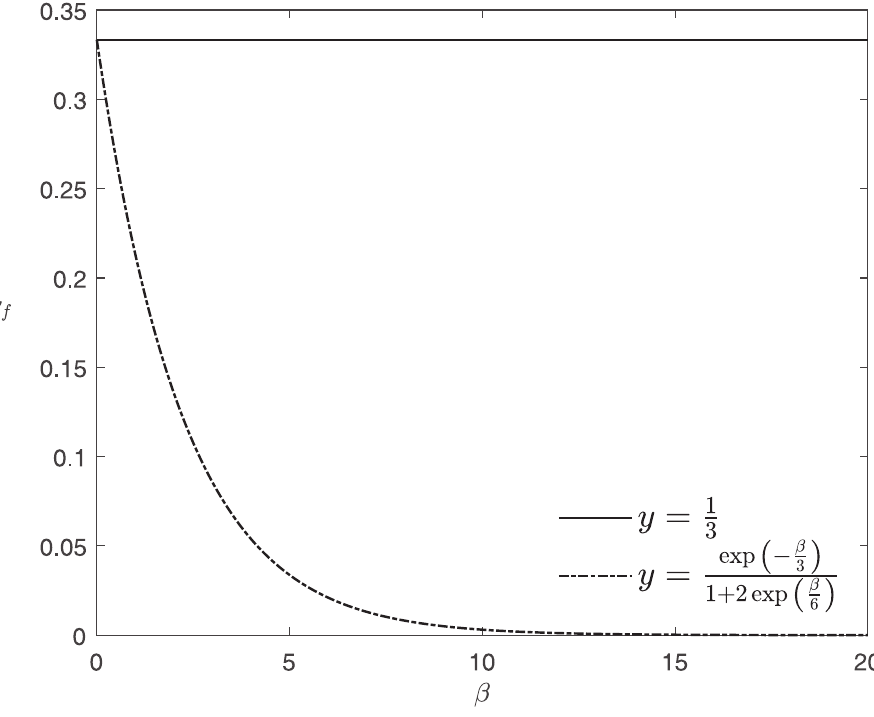
Fig 2. Aggregated appraisals of Karimi et al. (2006) [75] according to De Pretis et al. (2019) [78] (solid line) and EA 3 (dash-dot line). The latter, lower, curve displays the behaviour with respect to the cautiousness parameter β . Both curves agree for β = 0 where EA 3 equals the weighted